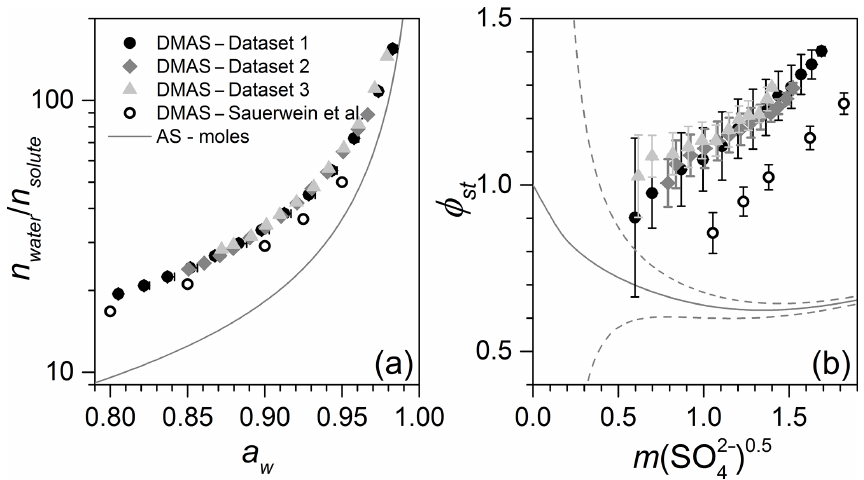
Figure 8. Evaluation of the reproducibility of measurements of the hygroscopic properties of DMAS. Symbols: black dots, dark grey dia- monds, light grey triangles – different datasets measured with the CK-EDB from DMAS solutions obtained independently; open circles – data from water activity measurements in Sauerwein et al. (2015); solid lines – (NH 4 ) 2 SO 4 calculations from the E-AIM model; dashed lines – uncertainty on (NH 4 ) 2 SO 4 osmotic coefficients corresponding to an error in a w of ±